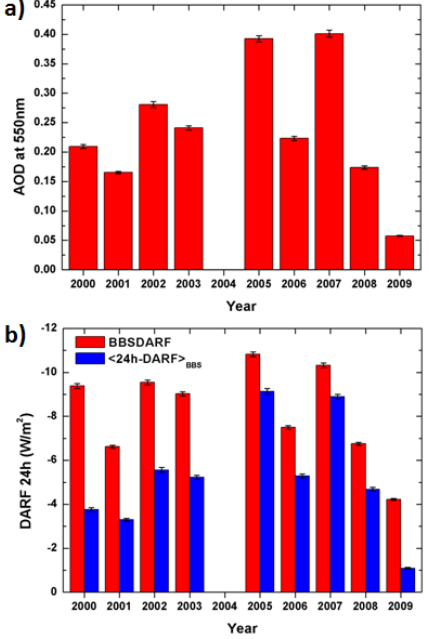
Figure 4. (a) MODIS mean aerosol optical depth at 550nm over Amazonia during the dry season and (b) mean direct aerosol radia- tive forcing of aerosols (24h-DARF) during the peak of the biomass burning season (August to September) from 2000 to 2009 obtained by the methodology applied by Sena et al. (2013) (BBSDARF) and by the methodology proposed in this work ( (cid:104) 24h-DARF (cid:105) BBS